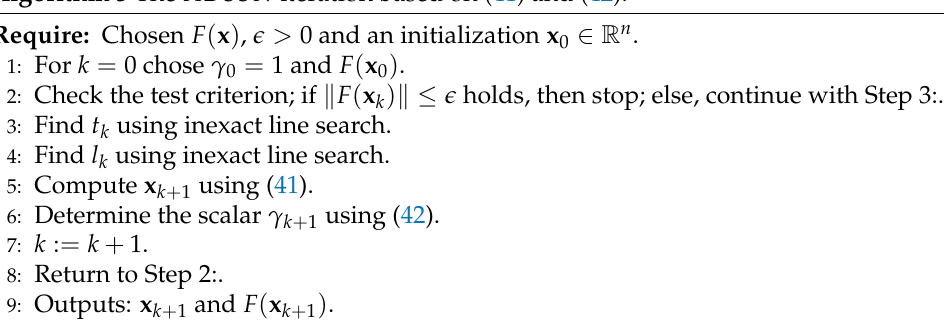
Algorithm 3 The ADSSN iteration based on (41) and